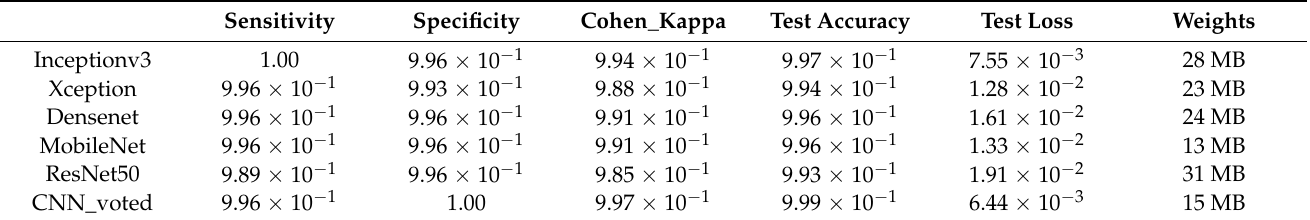
Table 4. Results achieved from the various learners with the industrial casting dataset.